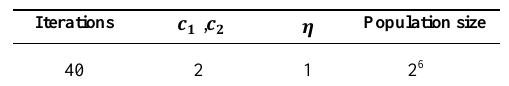
Figure 10. Angles of quad